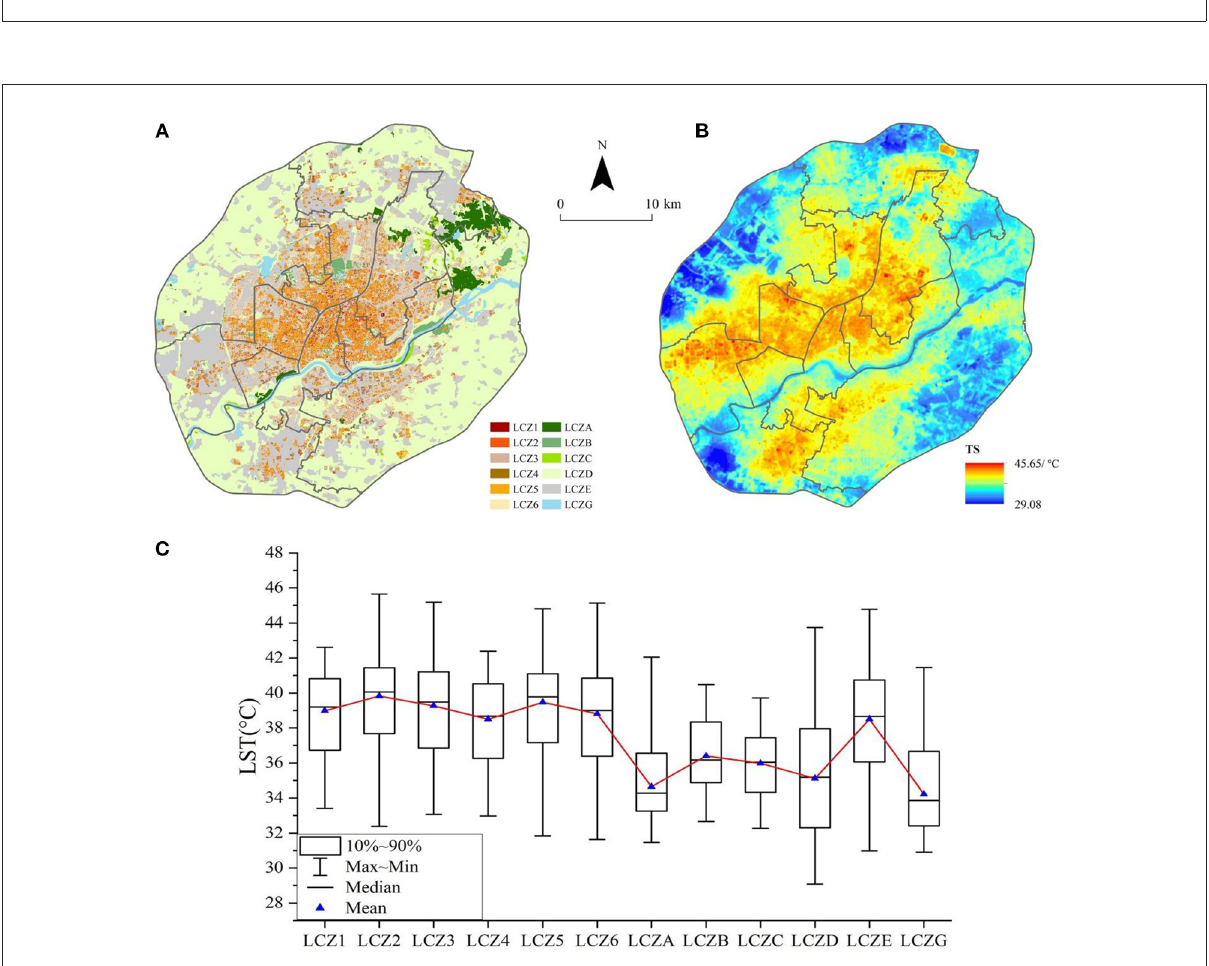
FIGURE4 Thermal characteristics of the LCZ; (A) LCZ classification results; (B) Inversion results of land surface temperature in the study area; (C) Boxplot of LST distribution under LCZ.